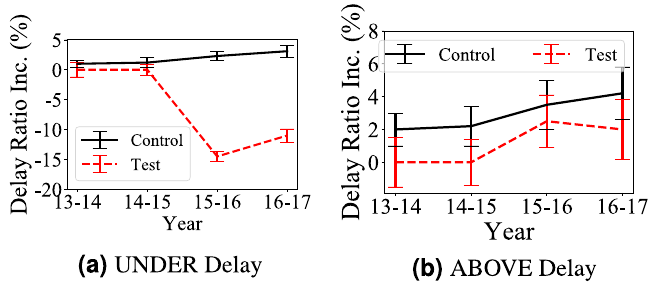
Figure 3. Delay increase in underground or aboveground areas covered by aboveground upgrades (test areas) and similar area not covered by aboveground upgrades (control areas).